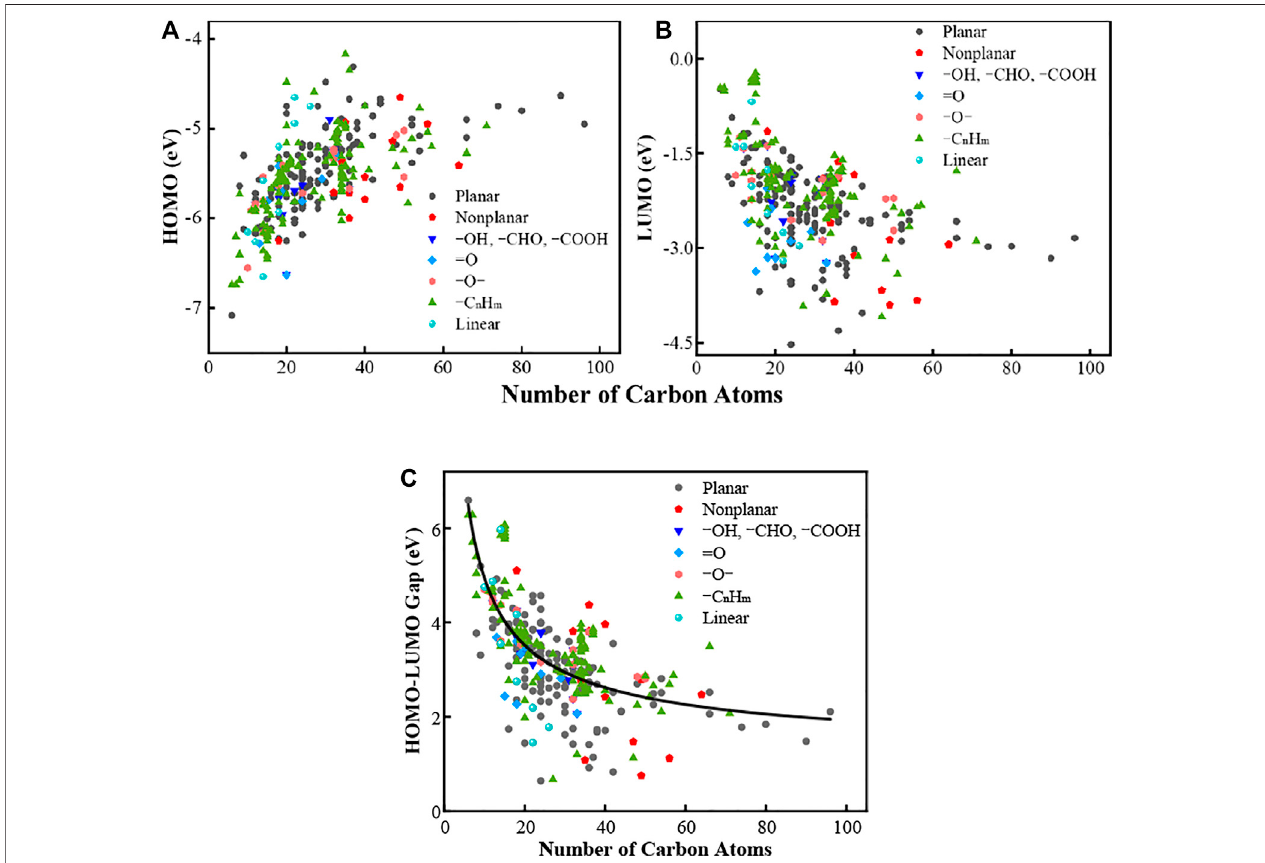
FIGURE1|(A) HOMOenergies ofallPAHmolecules. (B) LUMOenergies ofallPAHmolecules. (C) HOMO-LUMOgapofallPAH molecules.Thelineis fi ttedusing